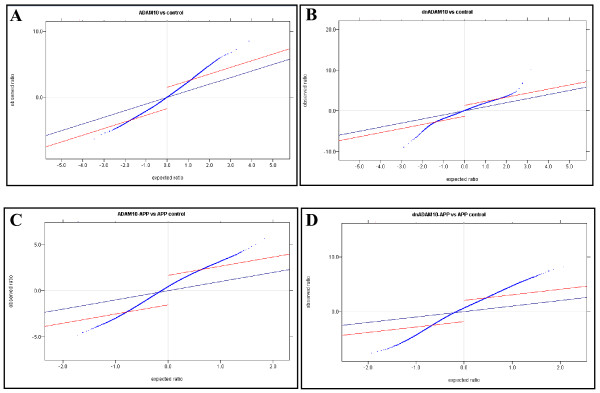
Significance analysis of microarrays. The SAM plots represent the differentially expressed genes of mono-transgenic (A and B with FDR 0.5), and double-transgenic mice (C and D with FDR 0.0). The Delta parameter, represented by red lines, defines the significance field (-1.72/+2.23 (A: ADAM10 versus FVB/N), -1.36/+1.43 (B: dnADAM10 versus FVB/N), -1.56/+2.06 (C: ADAM10/APP[V717I] versus APP[V717I]), -2.85/+3.29 (D: dnADAM10/APP[V717I] versus APP[V717I])). Shown above the upper line are the genes upregulated significantly, and below the lower line the genes downregulated significantly.